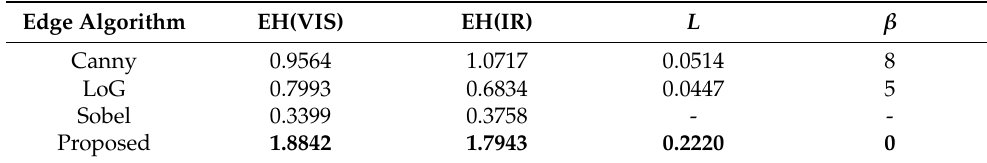
Table 1. Comparison of different edge algorithms.